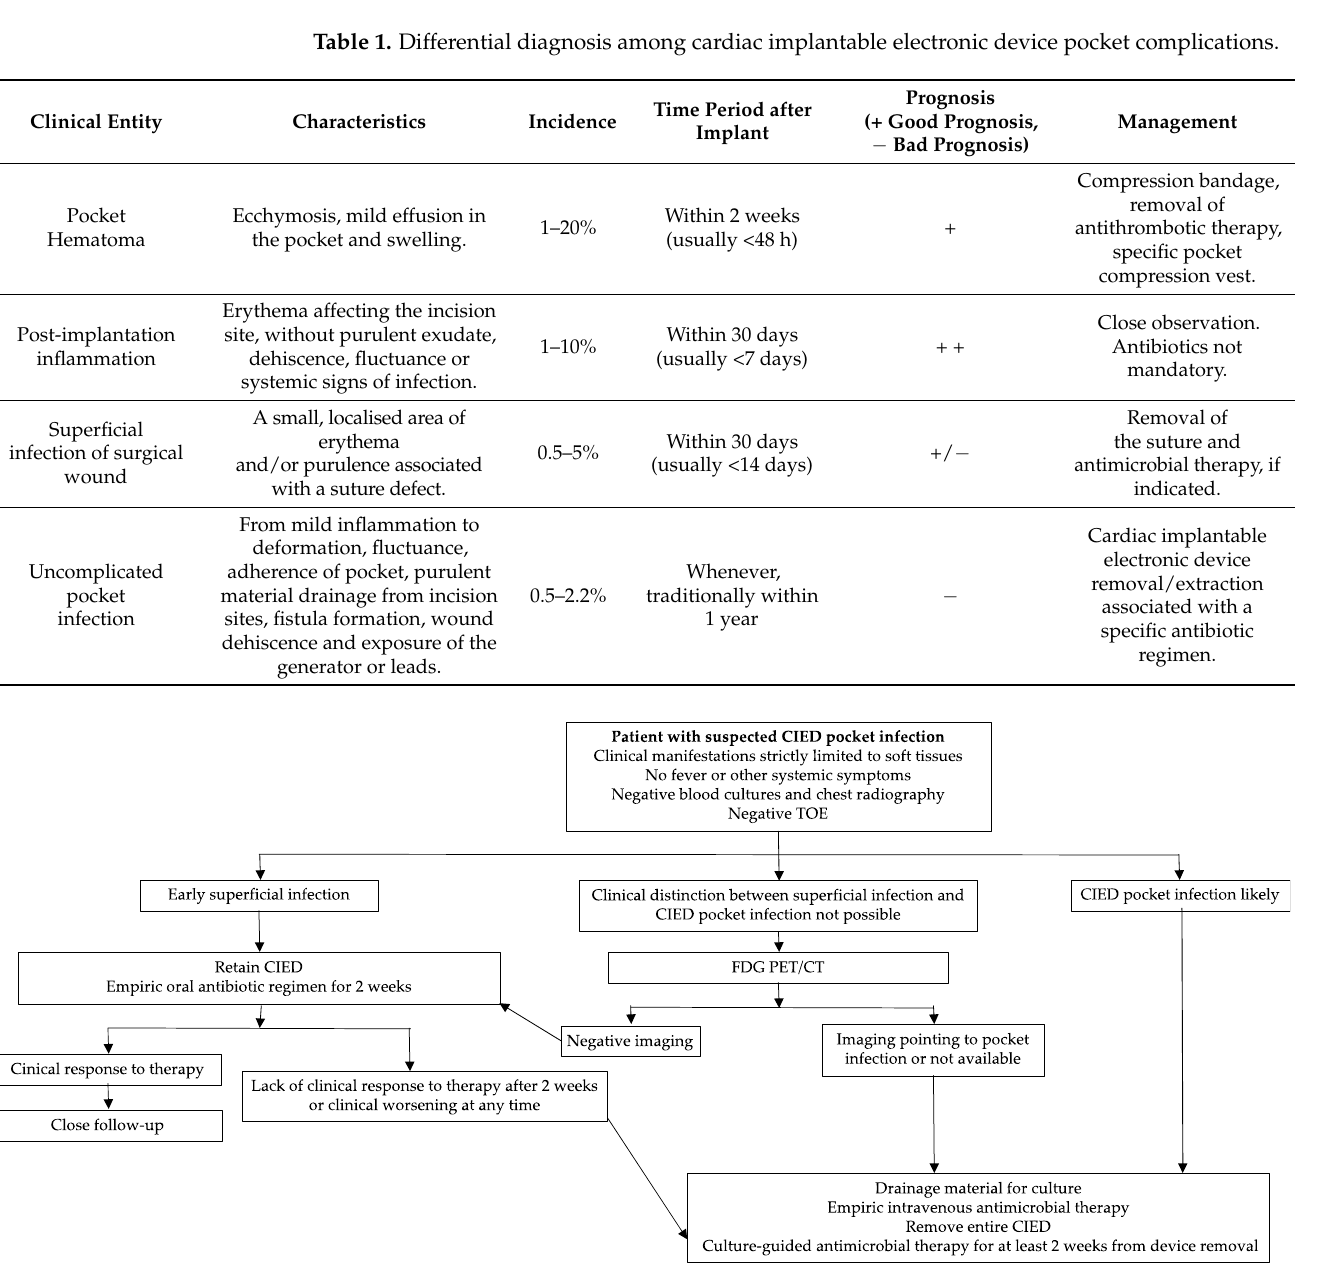
Figure 1. Proposed algorithm for the management of patients with suspected CIED pocket